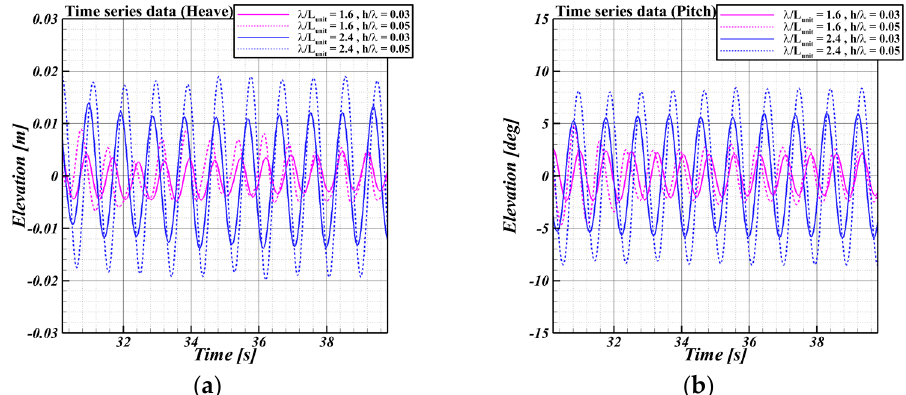
varies significantly.